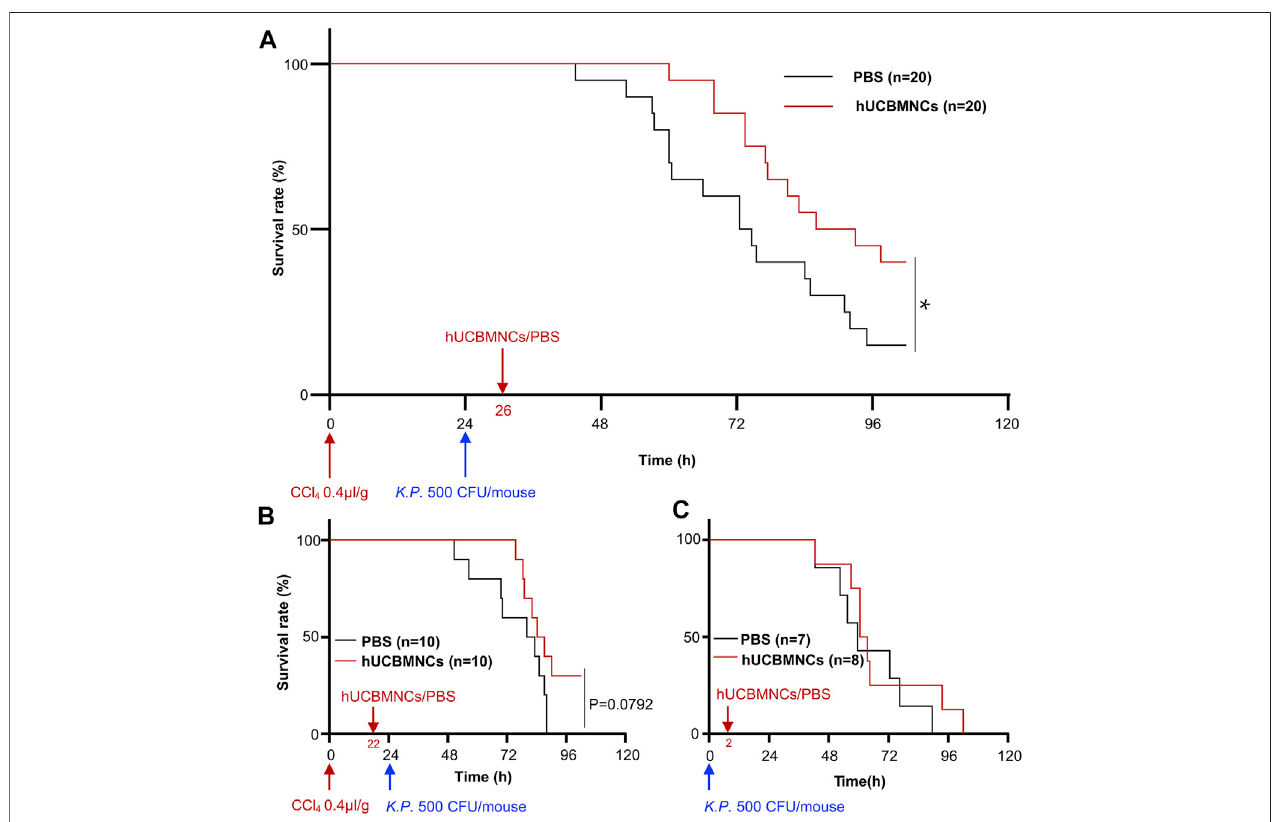
FIGURE 1 | hUCBMNCs treatment prolonged mice survival time in DAMPs plus PAMPs-induced liver injury. (A) hUCBMNCs showed a therapeutic effect on CCl 4 plus Klebsiella pneumoniae ( K.P. ) -induced liver injury. CCl 4 (0.4 μ l/g) plus K.P. (500 CFU/mouse) were administrated at 0 and 24h, respectively, to induce acute liver injury,andhUCBMNCs( n =20)orPBS( n =20)wasappliedat26hfortheobservationoftherapeuticeffects. (B) PretreatmentofhUCBMNCsonCCl 4 plus K.P. -induced liverinjury hardlyimproved the mice survival. CCl 4 (0.4 μ l/g) plus K.P. (500 CFU/mouse) wasadministrated at 0and 24h, respectively, todevelop liver injury model, and hUCBMNCs ( n = 10) or PBS ( n = 10) was applied at 22h for the veri fi cation of preventative effects. (C) hUCBMNCs had no therapeutic effects on K.P. -induced liver injury. K.P. (500 CFU/mouse) was administrated intraperitoneally at 0h, and hUCBMNCs ( n = 7) or PBS ( n = 8) was applied at 2h post infection. *, p <